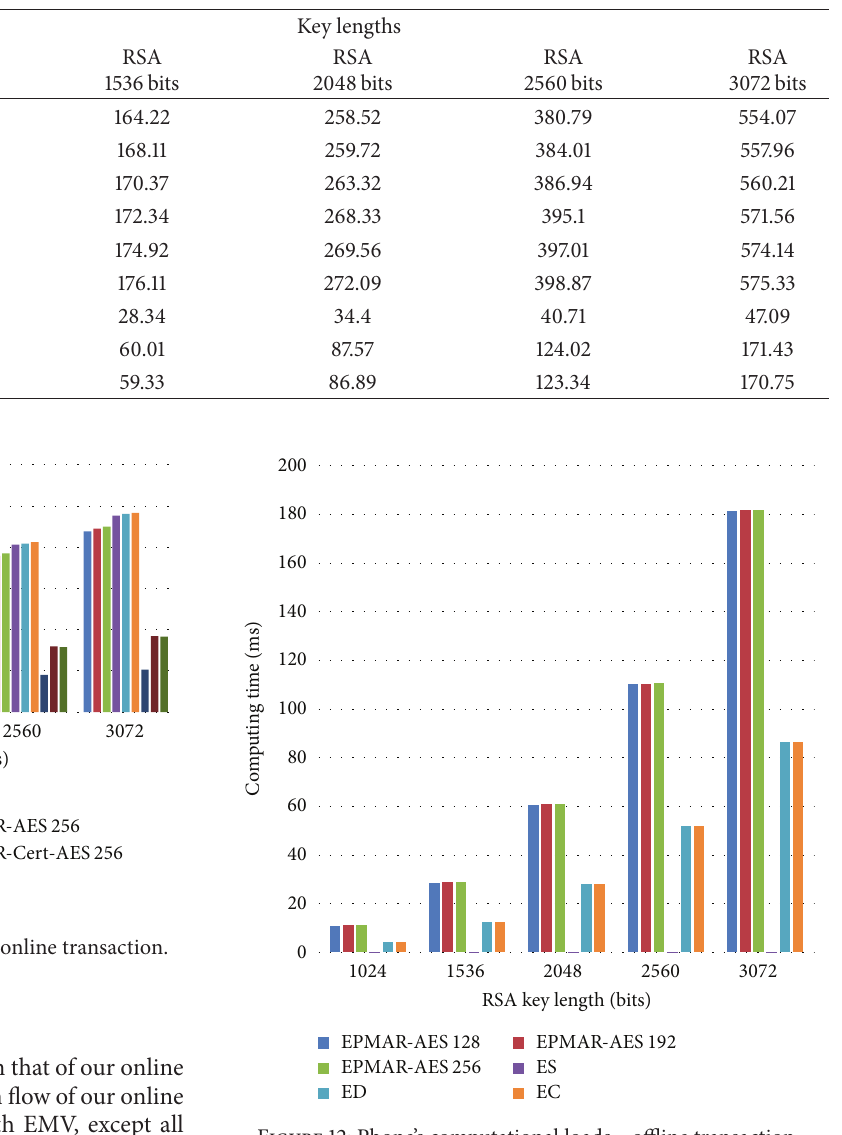
Figure 12: Phone’s computational loads—offline